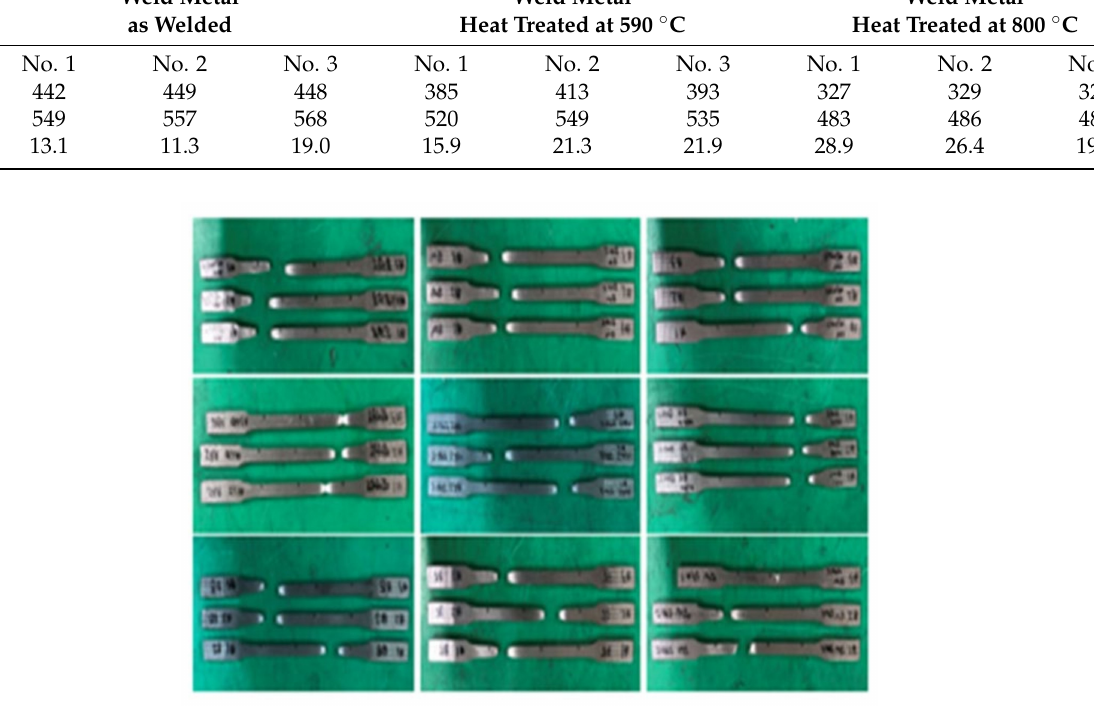
Figure 7. Specimens after tensile tests.